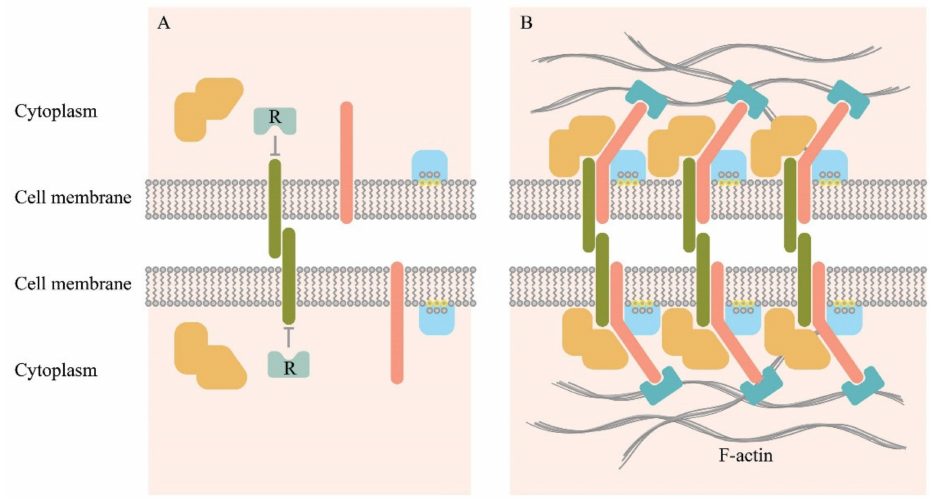
Figure 2. Schematic representation of individual molecules freely di ff using on the membrane surface ( A ), and a cluster of the intercellular adhesive complexes ( B ). Adhesion molecules (deep green) initiate binding, which also may involve other transmembrane proteins (pink), cytoplasmic proteins that can bind to the cytosolic part of the transmembrane proteins (orange). It also involves lipid groups present on the inner surface of the plasma membrane (yellow), and proteins with lipid-binding domains (light blue). Clustering may lead to the displacement of negative regulators associated with the cytosolic part of the adhesion molecules (R). Actin microfilaments stabilize macromolecular clusters through actin-binding proteins (cyan)